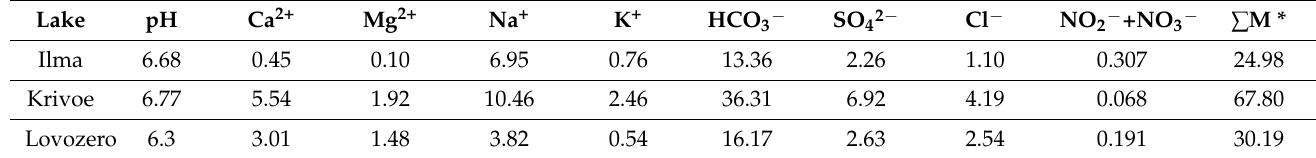
Table 2. The content of the main cations and anions in the water samples of the studied lakes, mg/L.